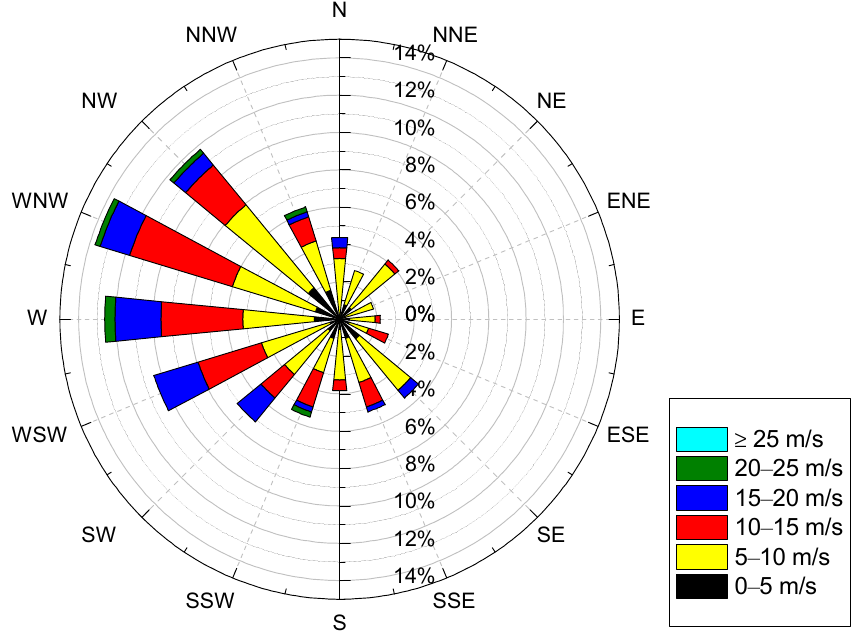
Figure 3. Wind rose for the city of Lodz in 2019 (own study based on data from source: [36]). To obtain more accurate calculation data, 2019 was divided into three sub-periods: the “summer” period (from April 1 to September 30) and two “winter/heating” periods. In the “1st winter/heating period” (from 1 January to 31 March), the average air temperatures were lower (Table 1) than those in the “2nd winter/heating period” (from 1 October to